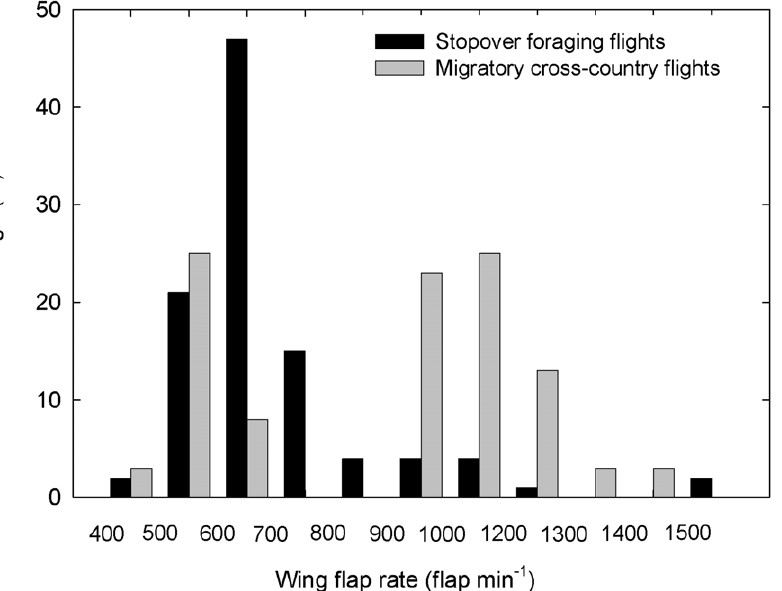
Figure 7. The distribution of wing beat frequency of European bee-eaters during stopover (foraging flights) and cross-country flight (flap-glide flights).